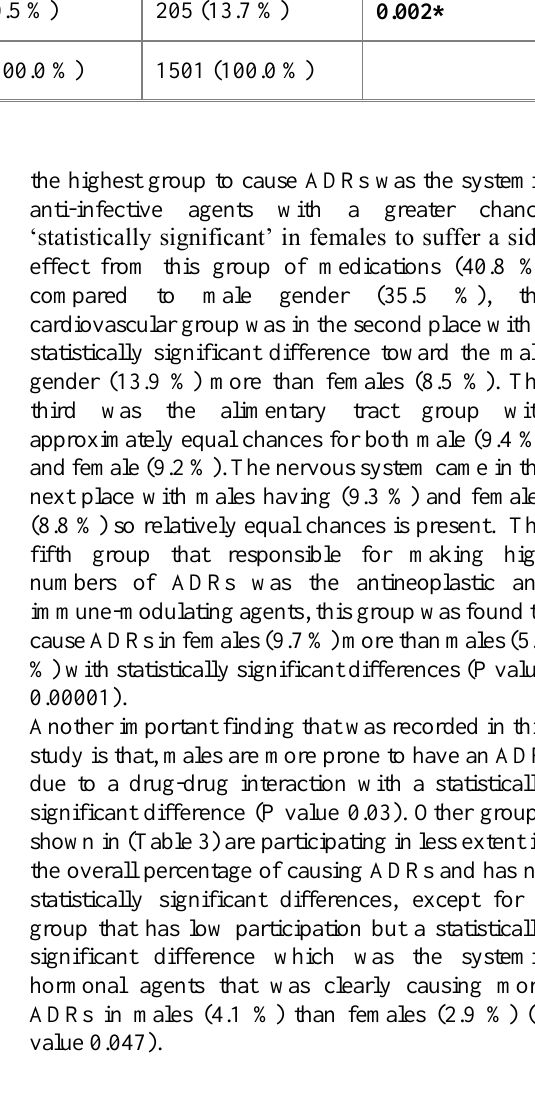
Number and percentage of ICSR